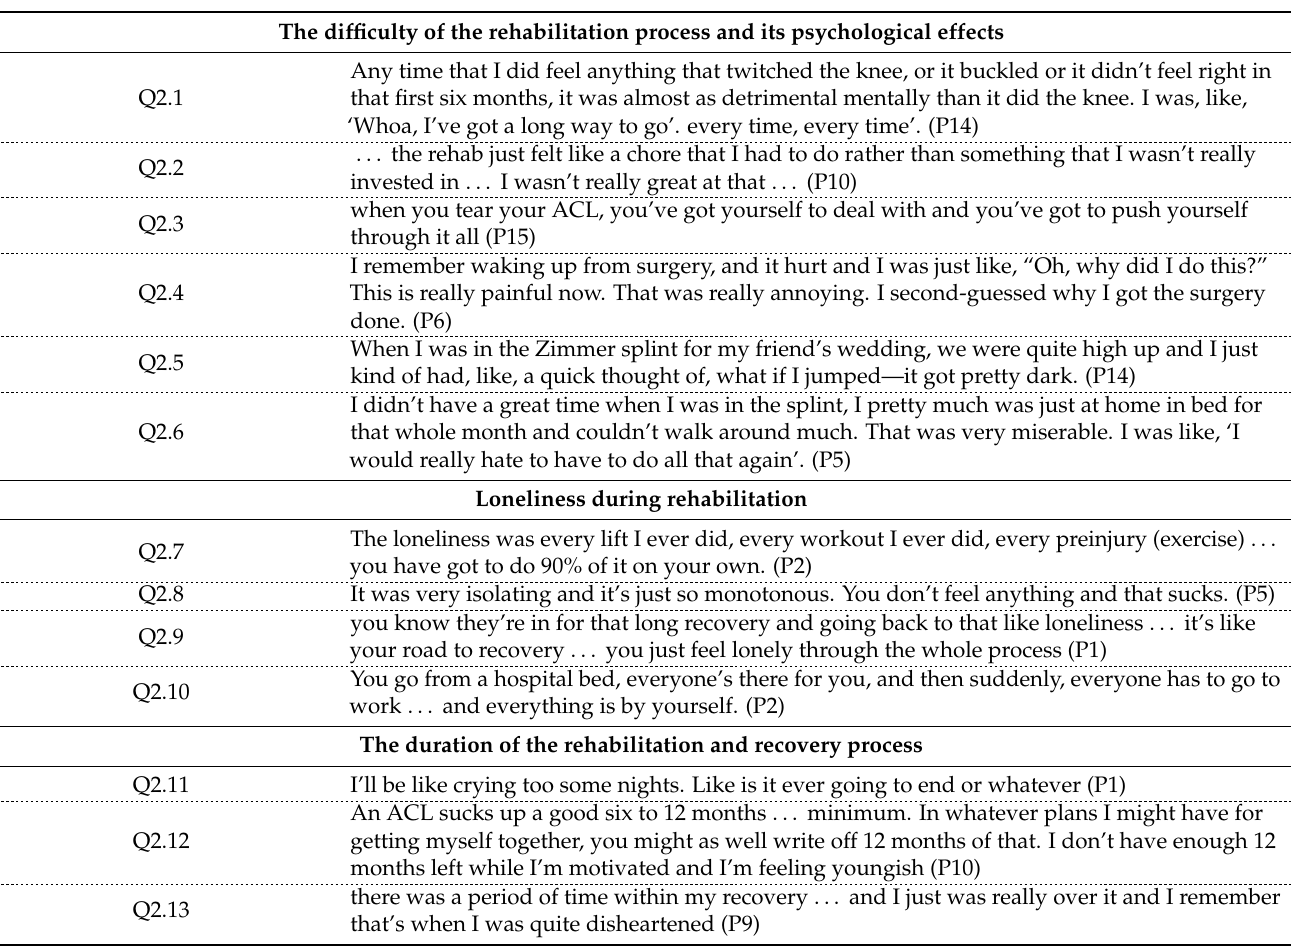
Table 3. Supporting quotes to theme 2—difficulty of the ACL rehabilitation journey driving